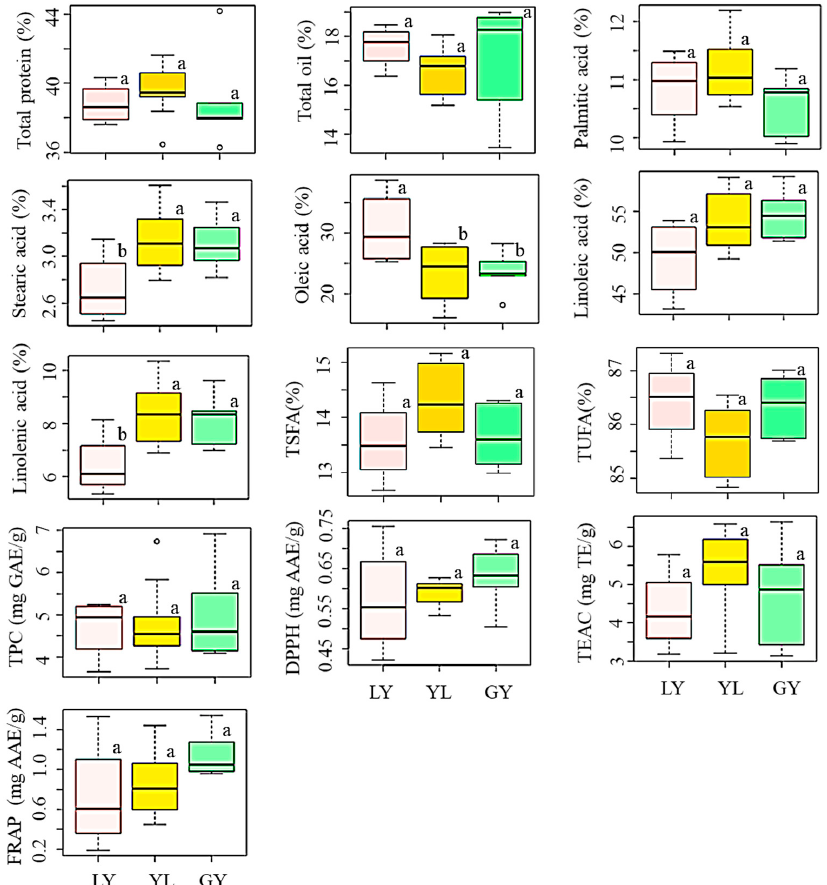
Figure 2. Variation of total protein, total oil, individual and total fatty acids, total phenolic content, and antioxidant activities in soybeans according to seed coat color. Different letters (a,b) on boxplots in a specific group represent the means that are significantly different ( p < 0.05). TEAC: Trolox equivalent antioxidant capacity; DPPH: DPPH-radical scavenging activity; FRAP: Ferric reducing antioxidant power; GY: Greenish-yellow; LY: Light-yellow; TPC: Total phenolic content; TSFA: total saturated fatty acid; TUFA: Total unsaturated fatty acid; YL: Yellow.